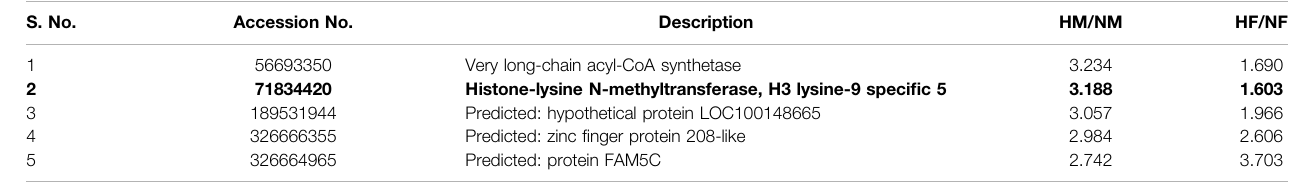
TABLE 4 | Top 5 upregulated proteins retrieved from uniformly regulated (upregulated) in both male and female zebra fi sh brain induced by acute hypoxia. S.